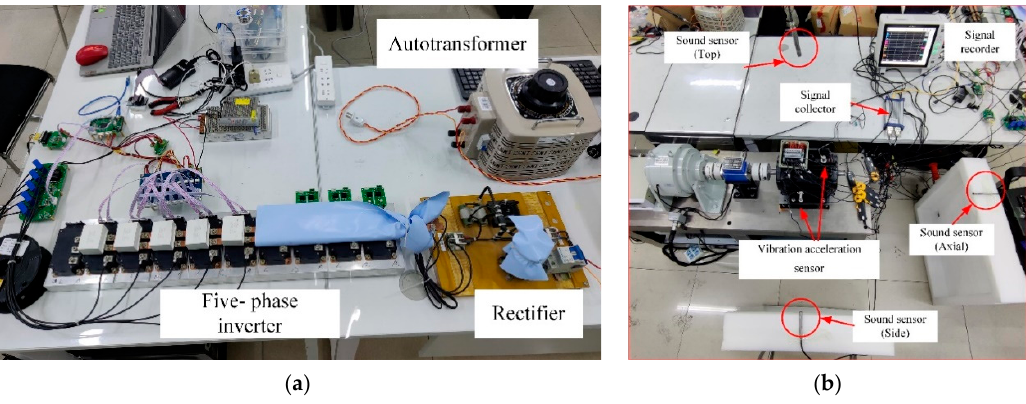
Figure 3. Schematic diagram of sensors layout.